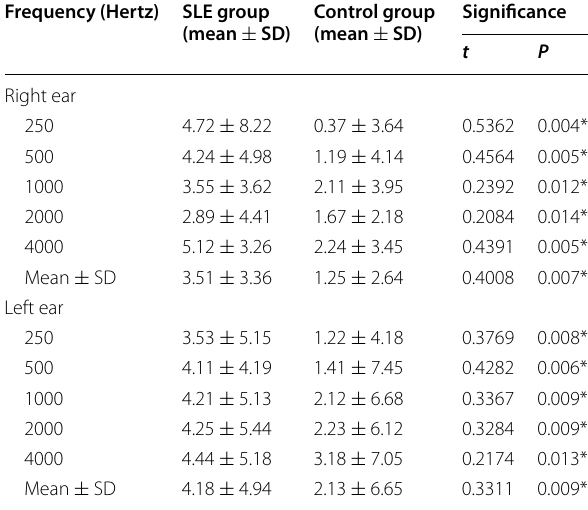
* P 0.05 significant. SLE systemic lupus erythematosus ≤ =